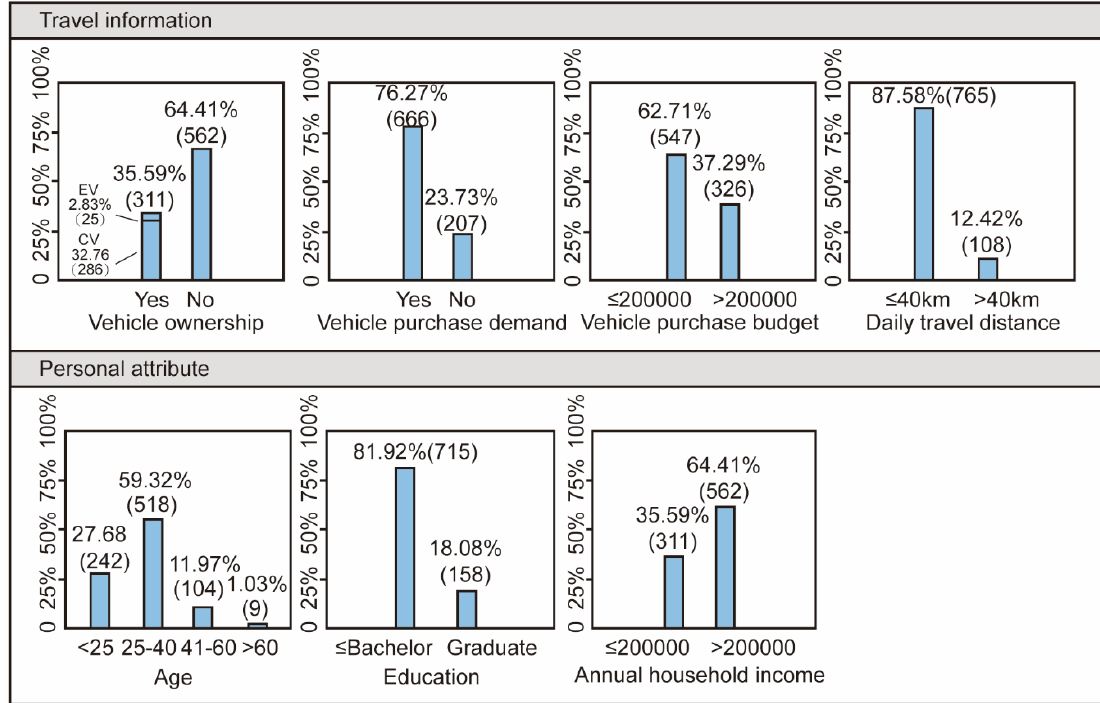
Figure 6. Statistics of basic information in the survey.